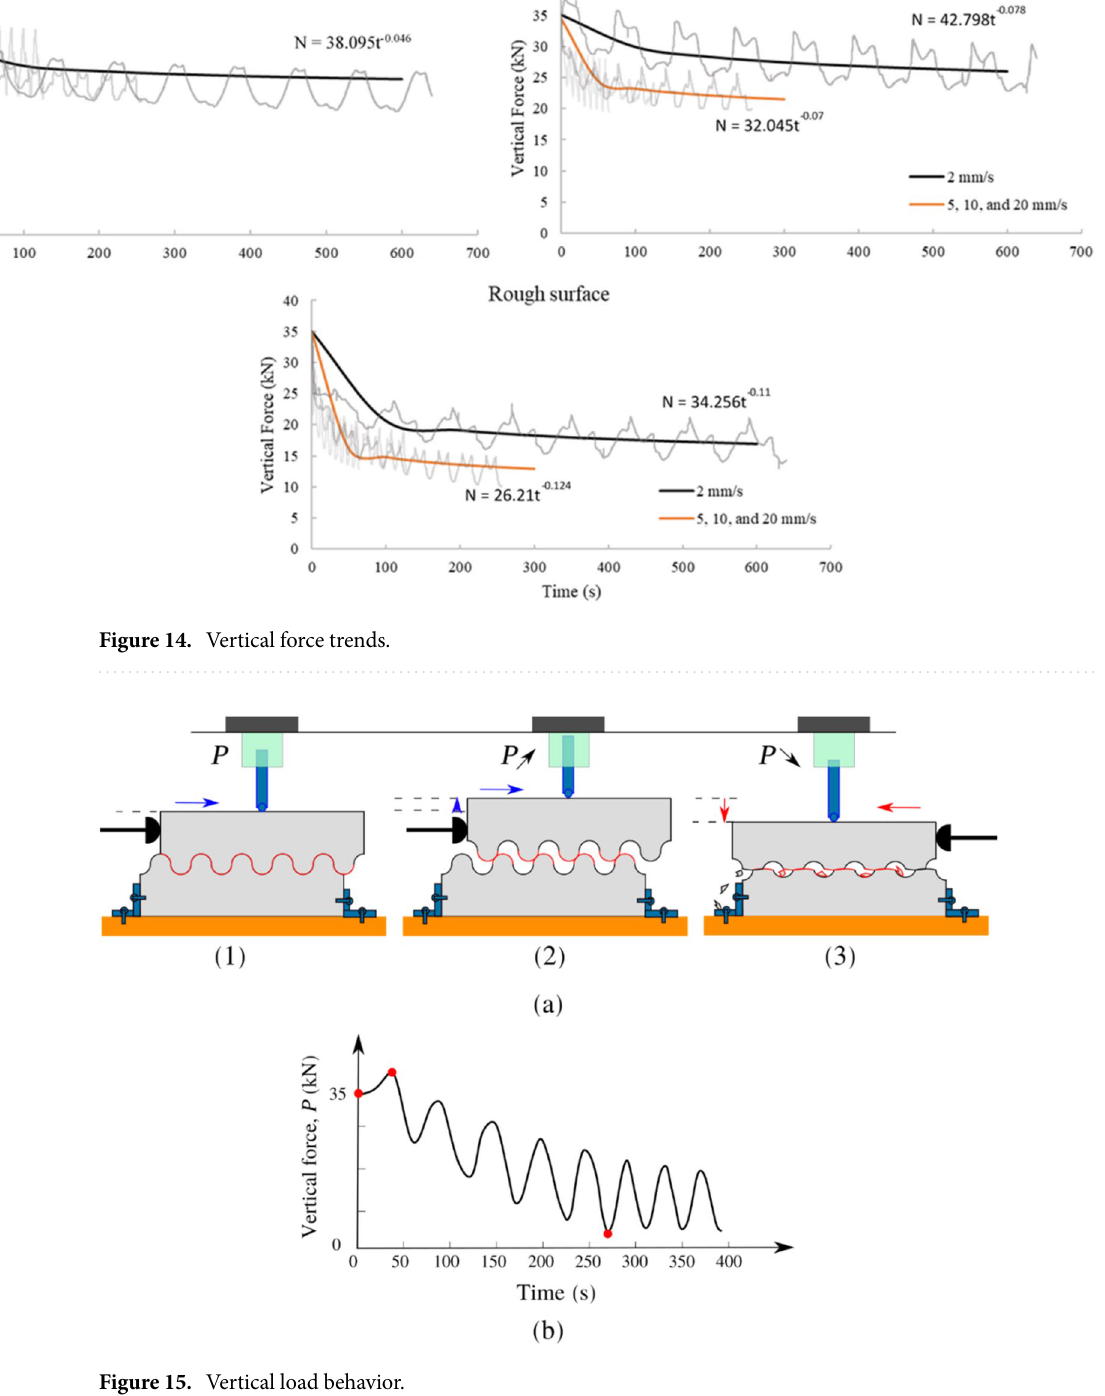
Figure 15. Vertical load